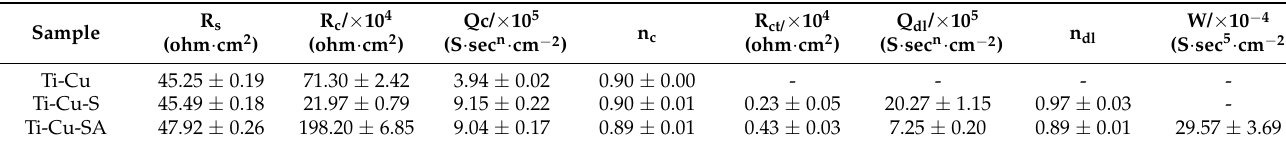
Table 2. Electrochemical data obtained from EIS.